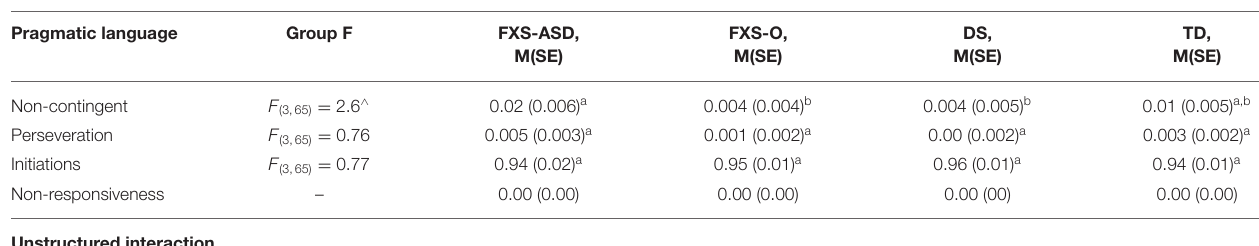
TABLE 4.2 | Group differences in pragmatic language in parents of females. Structured